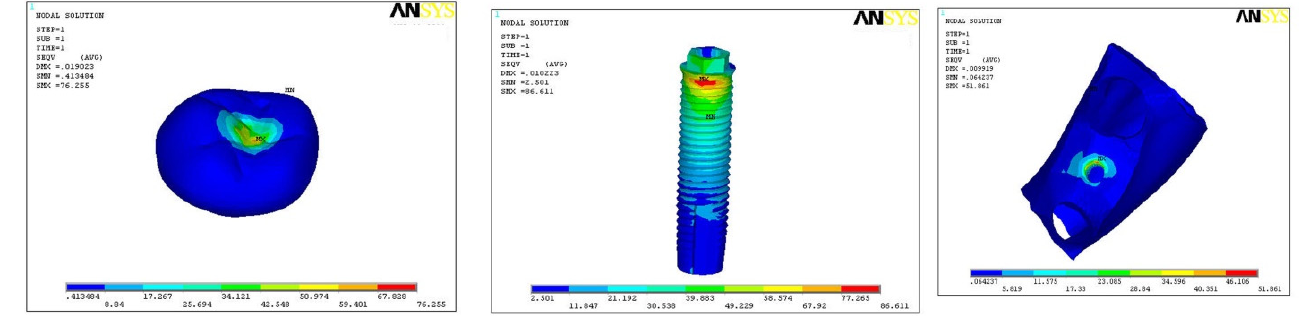
Figure 4. Pattern of stress in model A3. Table 3. Von Mises stress values in all